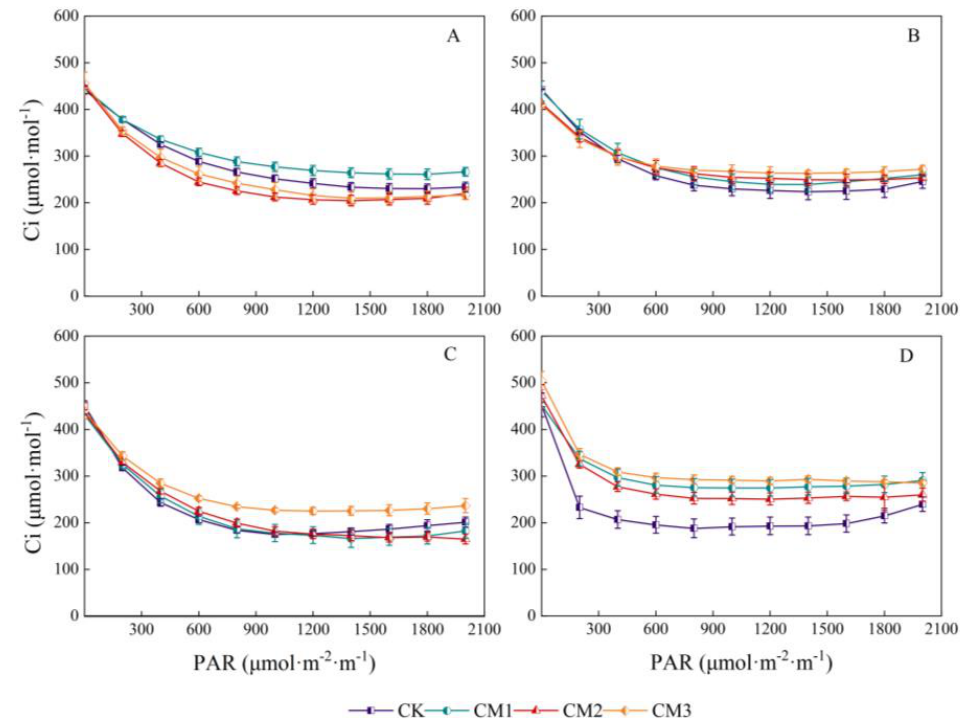
Figure 8. Light-response curves of cotton intercellular CO 2 concentration (Ci) under different con- figuration modes. ( A ): seedling period; ( B ): budding period; ( C ): flowering and boll development period; ( D ): maturation period.).